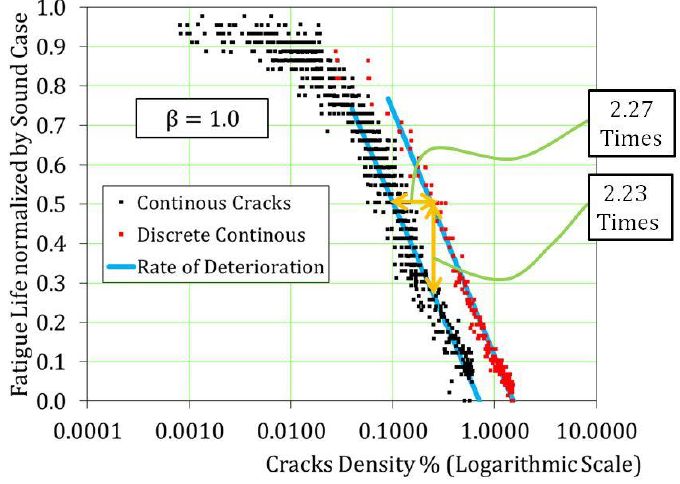
Figure 10. Relationship between cracks density and the remaining fatigue life.